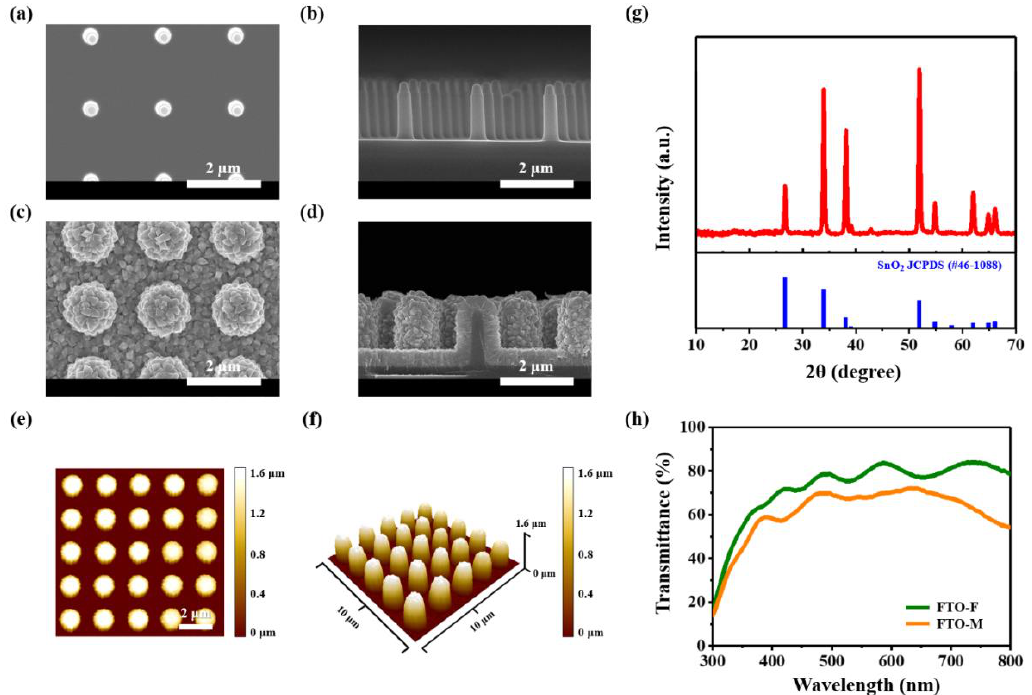
Figure 1. Scanning electron microscopy (SEM) images acquired from the fabrication procedure: ( a , b ) HSQ-M. ( c , d ) FTO-M. ( e , f ) AFM images of FTO-M. ( g ) X-ray diffraction (XRD) spectra of FTO-M. ( h ) Transmittance spectra of FTO-F and FTO-M.